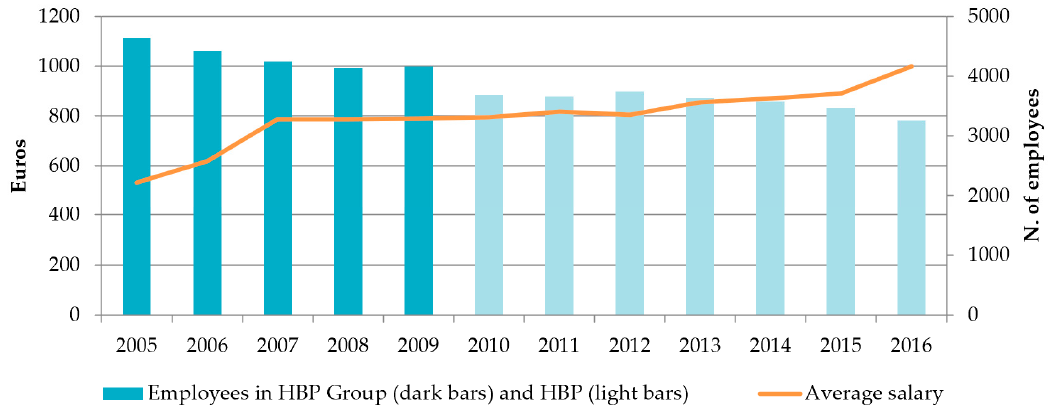
Figure 6. Employees in the Hornonitrianské bán ě Prievidza a.s. (HBP) Group and HBP and average salaries (2005–2016).